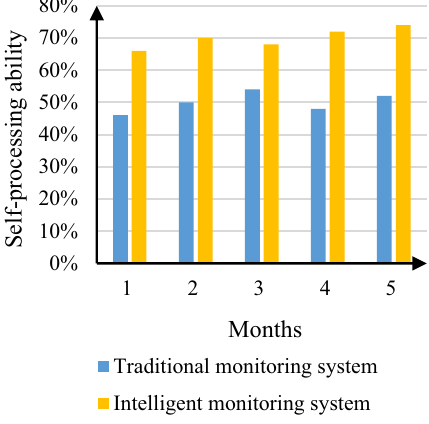
Fig. 8 Self-processing power comparison result